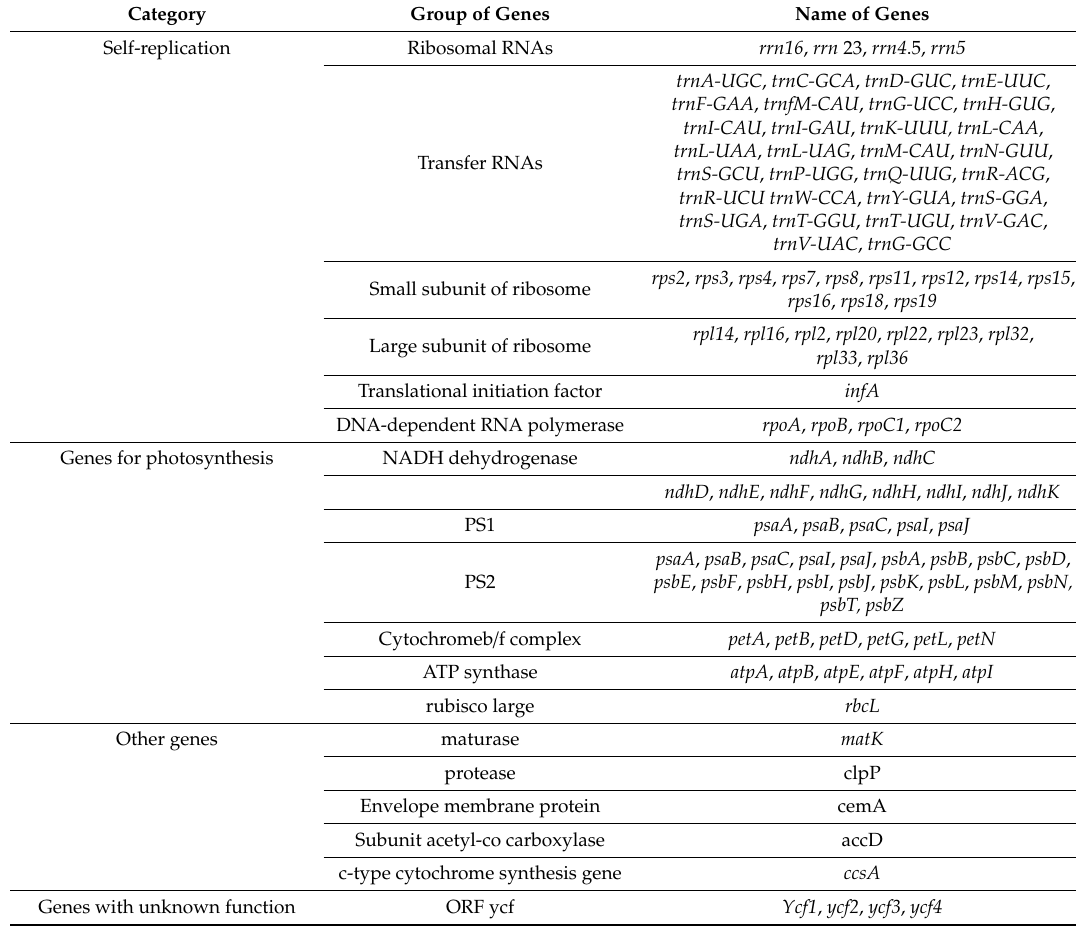
Table 1. Features of A. spinosa chloroplast genome. NADH (Nicotinamide Adenine Dinucleotide Hydrogen), ORF (Open Reading